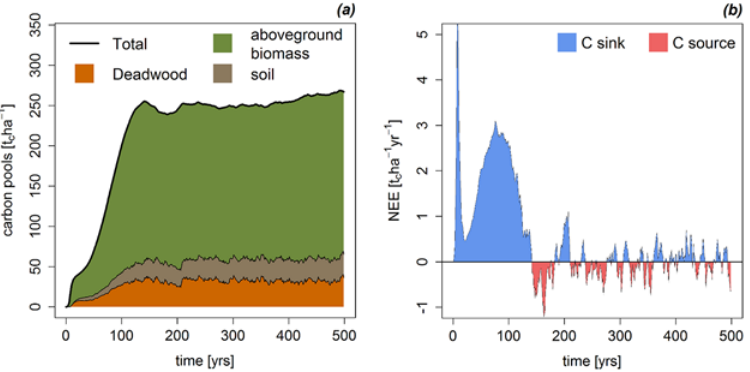
Fig 6. Carbon stocks and carbon fluxes. Simulated forest carbon pools and net ecosystem exchange (NEE) over time. (a) Presented is the amount of carbon in the living biomass, in the deadwood, and in the soil. (b) The NEE is a measurement of how much carbon is entering and leaving the forest. The simulated NEE started with a forest clearcut. Positive values indicate a carbon